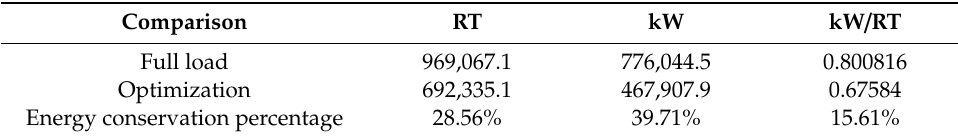
Table 4. Energy consumption comparison.